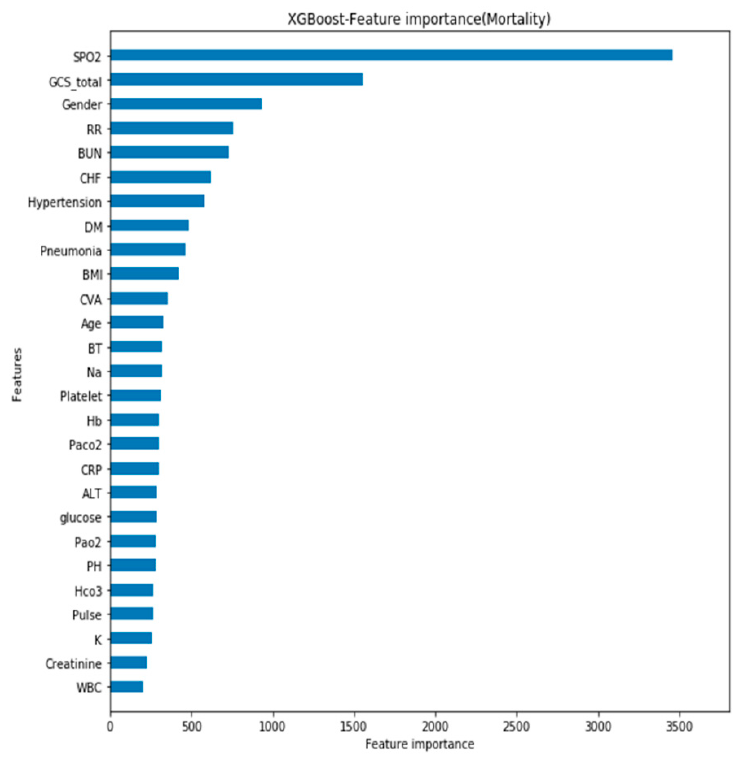
Figure 6. Feature importance of mortality.